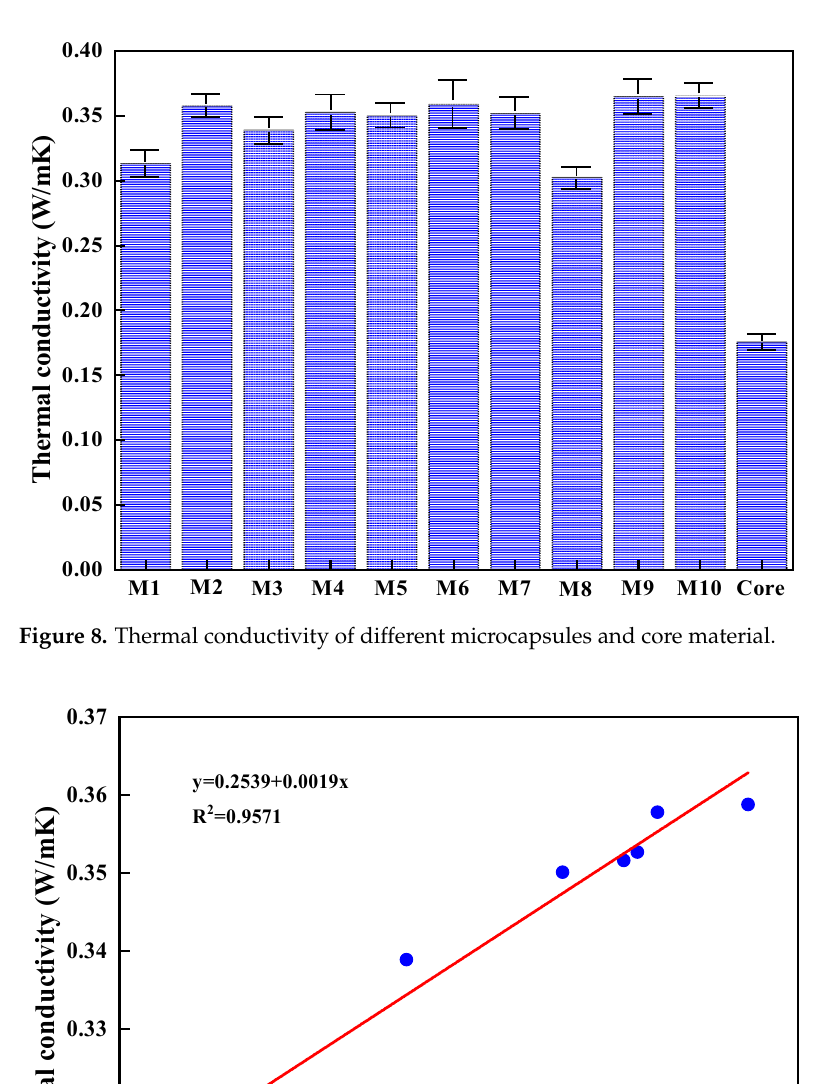
Figure 10. DSC spectra of different thermal cycles.